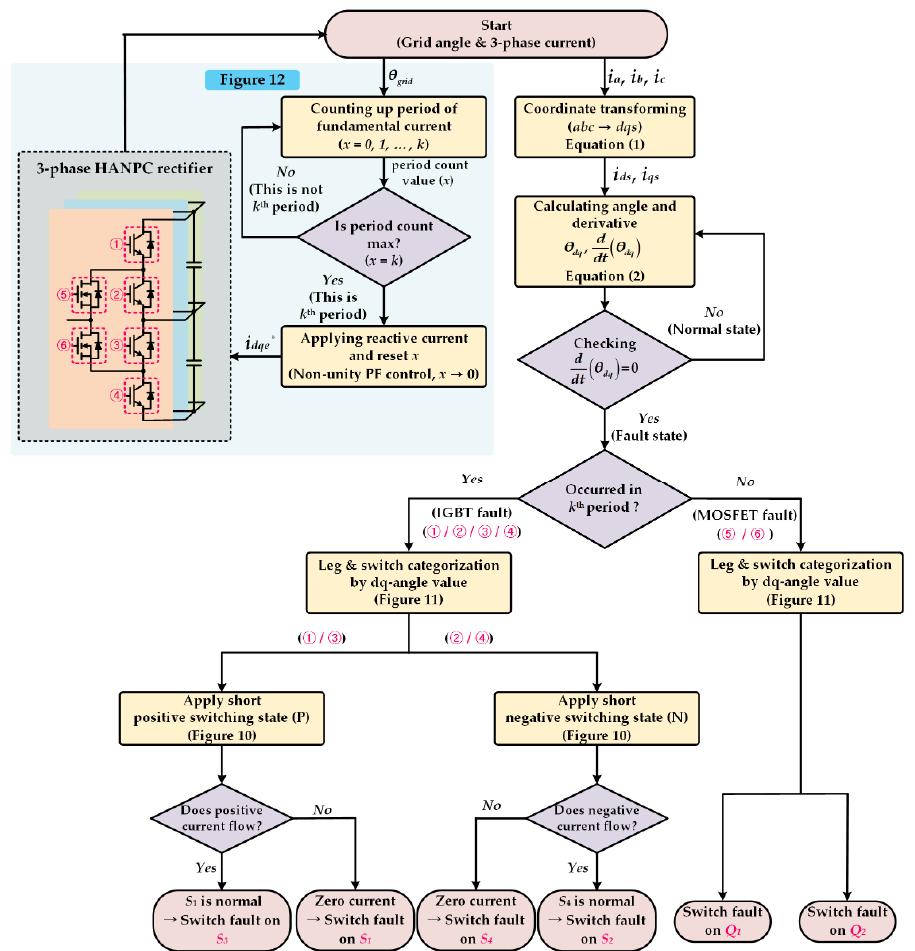
Figure 13. Flowchart of the proposed detection method for open-switch fault in the HANPC rectifier.